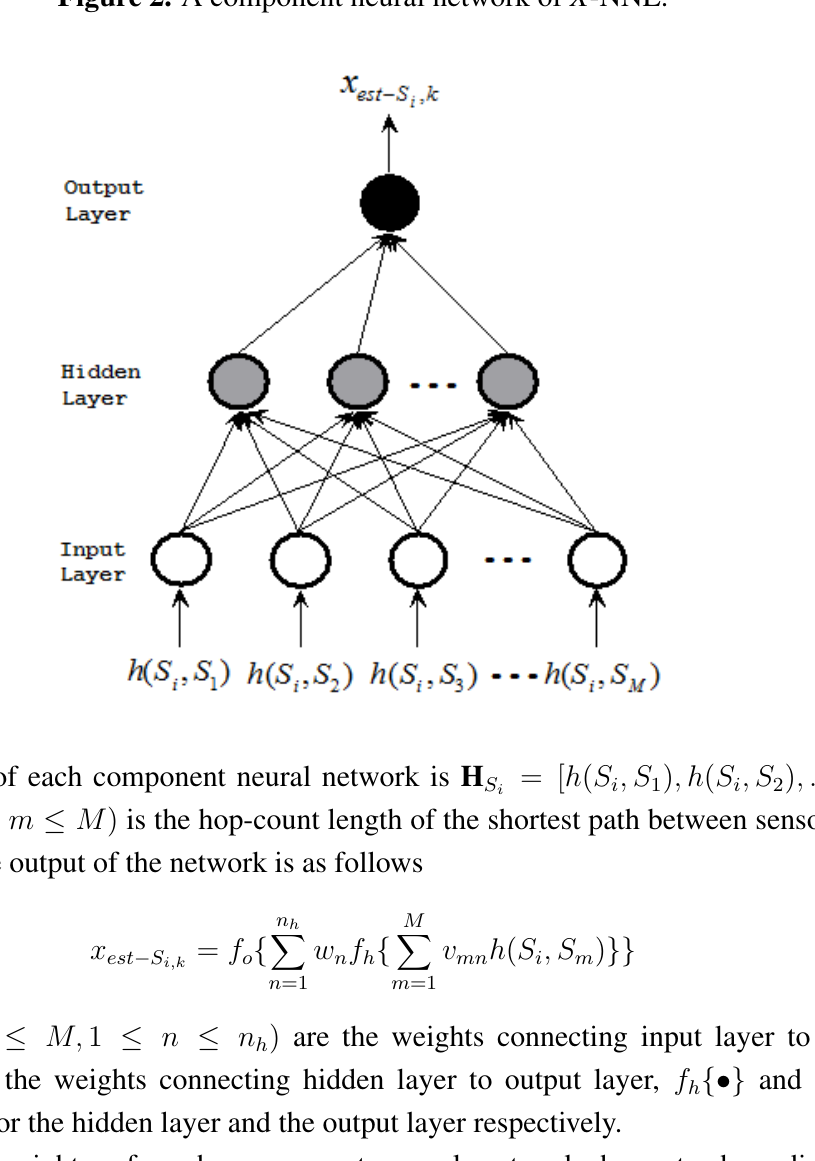
Figure 2. A component neural network of X